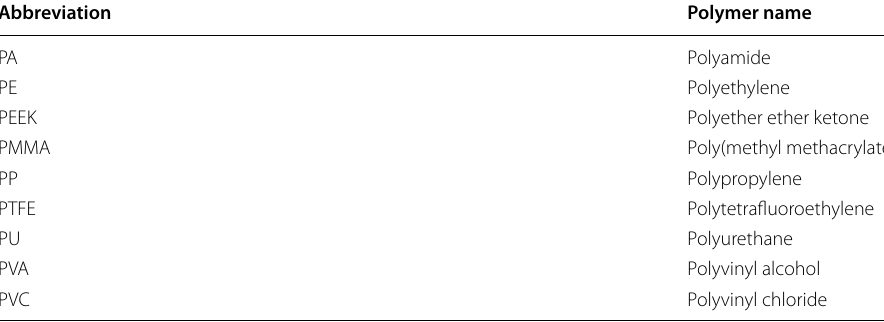
Table 1 Abbreviations and corresponding full names of polymers used in the manufacture of phantoms featured in this review